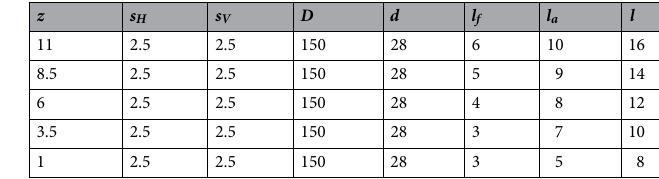
Table 2. Design results of anchors. z anchor height, s V vertical spacing of anchors (m), s H horizontal spacing of anchors (m), d diameter of reinforcement, D diameter of anchorage (mm)., l f length of the free section of the anchor (m), l a length of anchoring section of the anchor (m), l total length of the anchor (m).